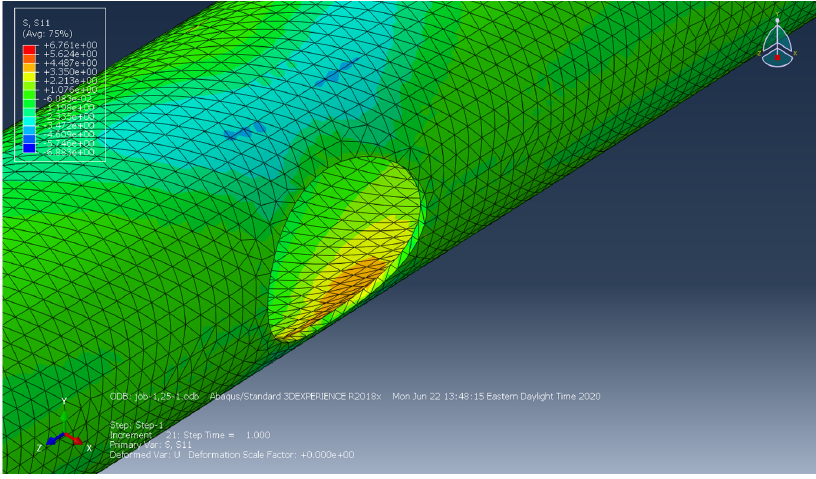
Figure 19. Aspect ratio 1.25-1 in transverse (X) direction.